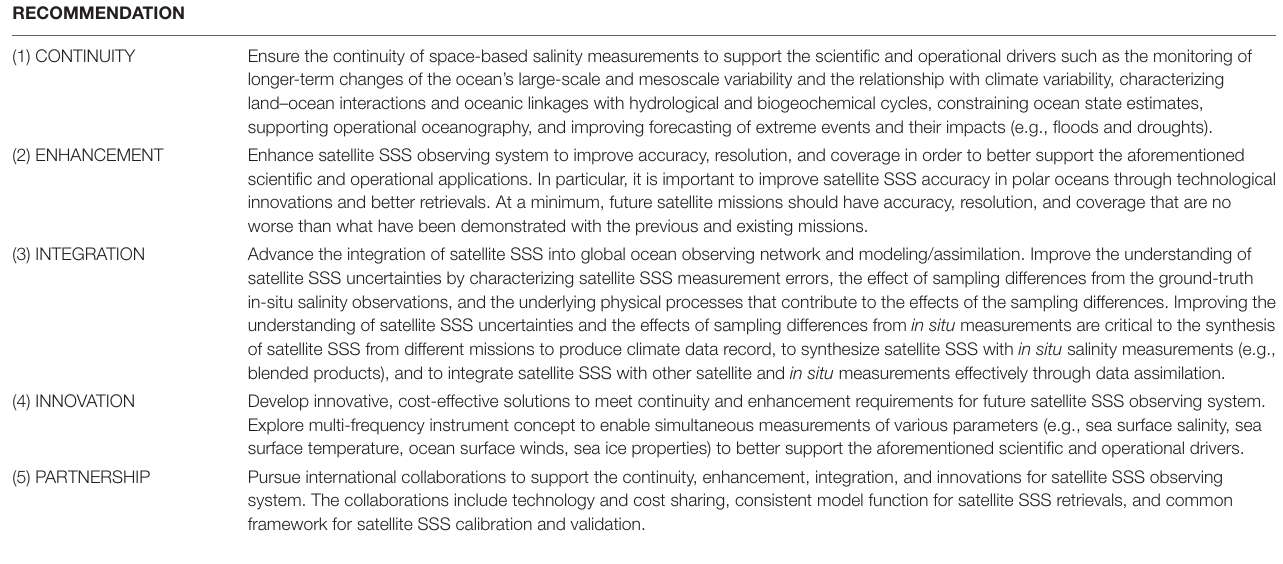
TABLE 1 | Summary of recommendations for salinity remote sensing for next decade.